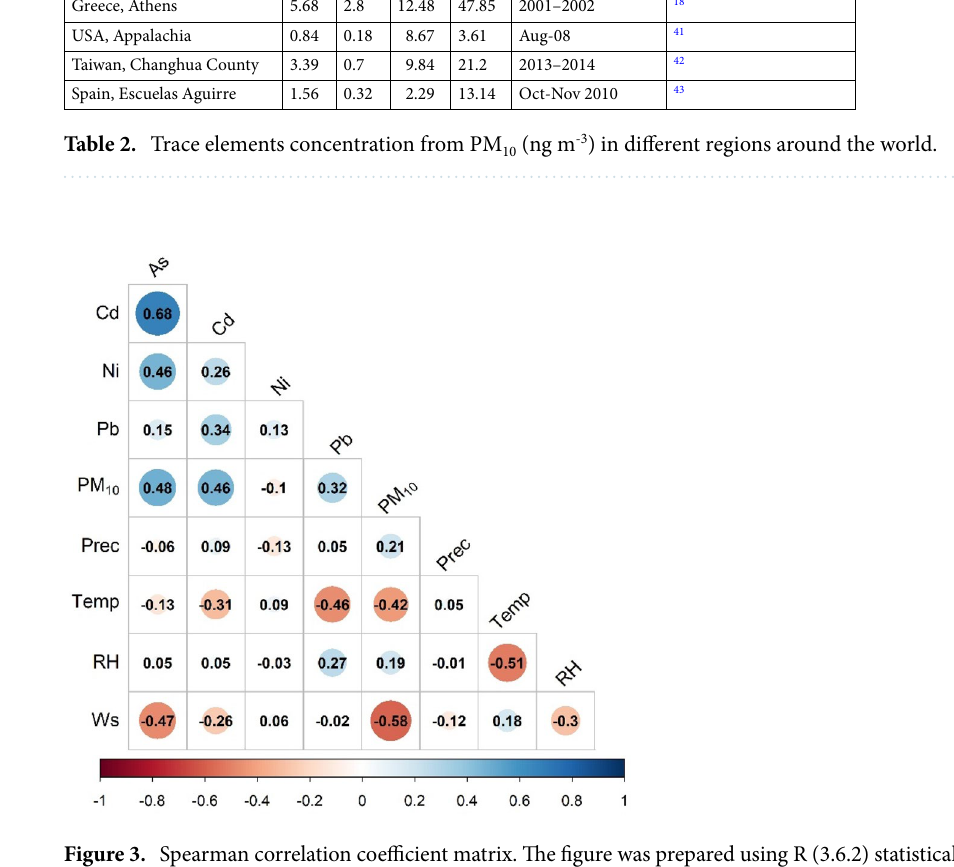
Figure 3. Spearman correlation coefficient matrix. The figure was prepared using R (3.6.2) statistical